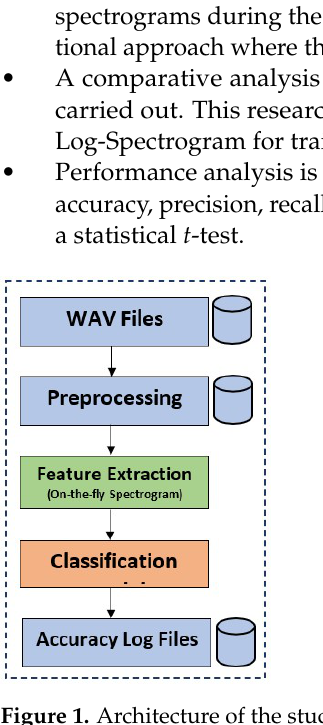
Figure 1. Architecture of the